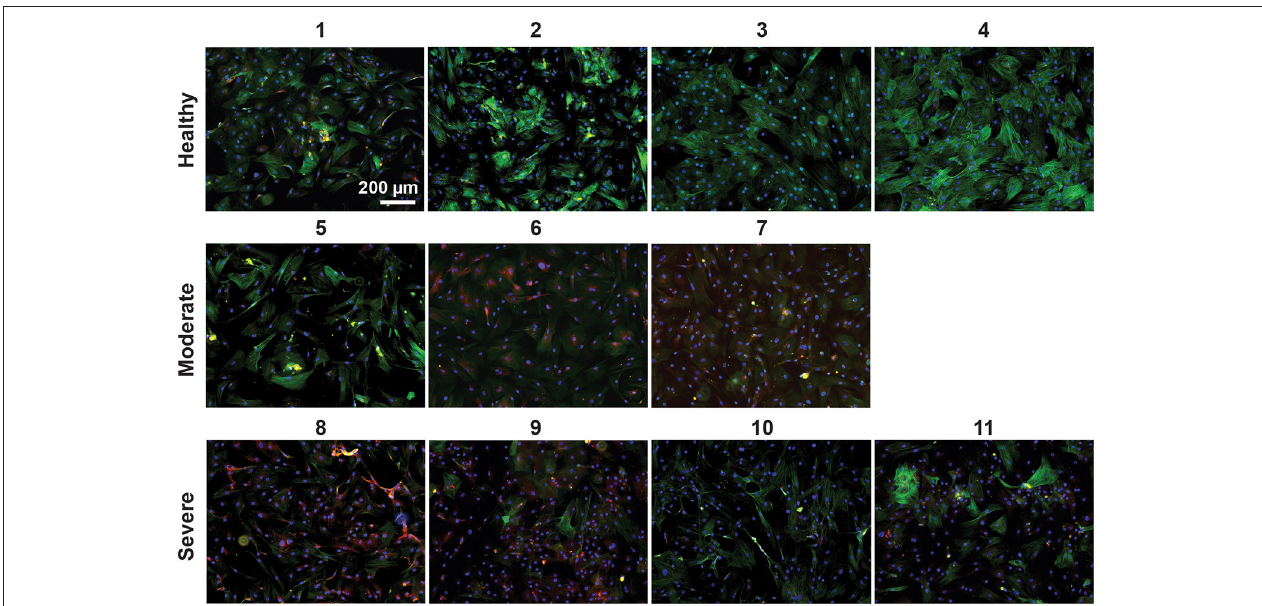
FIGURE 2 | VSMCs isolated from healthy (1–4), moderately (5–7), and severely (8–11) diseased patient arteries were stained for the contractile marker, ACTA2 (green), the atherogenic inflammatory marker, CD68 (red), and nuclei with DAPI (blue). Healthy VSMCs show greater ACTA2 expression and sev-VSMCs show greater CD68